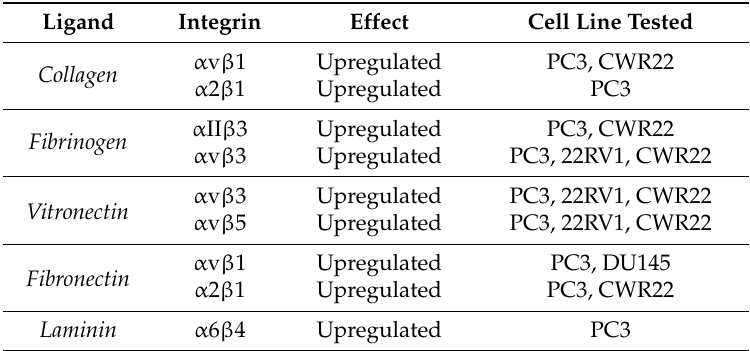
Table 1. Integrin expression in PC3, 22RV1 or CWR22 prostate cancer (PCa) cells. This table summarizes the alterations in well-known integrin receptors for collagen, fibrinogen, vitronectin, fibronectin, and laminin found in PC3, 22RRV1 or CWR22 PCa cell lines. Ligand Integrin Effect Cell Line Tested α v β 1 Upregulated PC3, CWR22 Collagen Upregulated